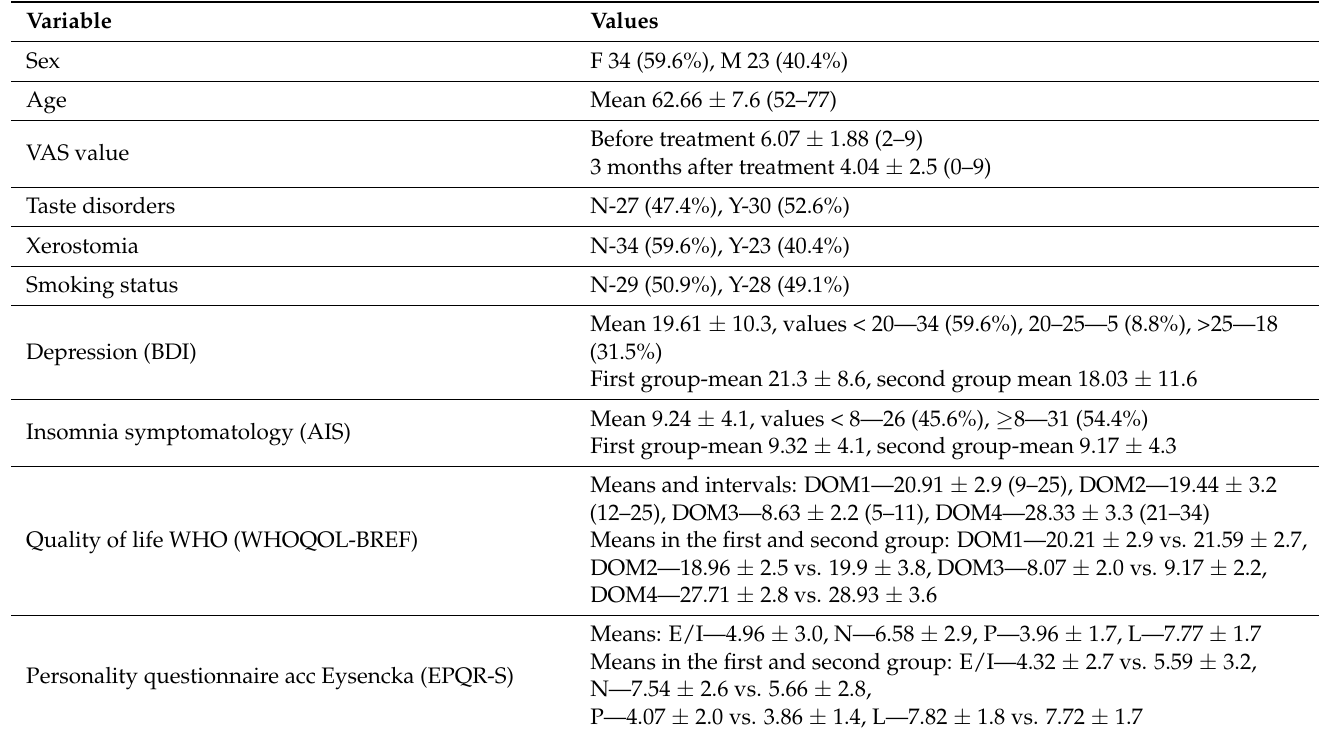
Table 2. Descriptive analysis for the whole group ( n = 57), clonazepam ( n = 28), and tongue protector ( n = 29)